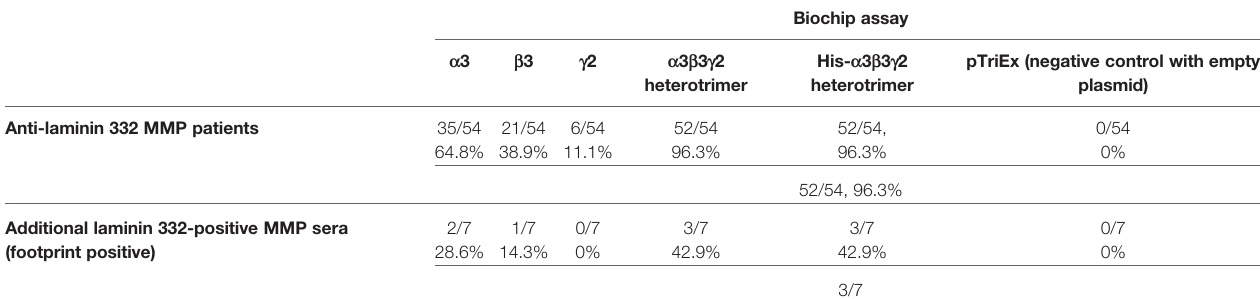
TABLE 1 | Reactivity of the anti-laminin 332 mucous membrane pemphigoid sera with the different laminin 332 chains by biochip mosaic assay.